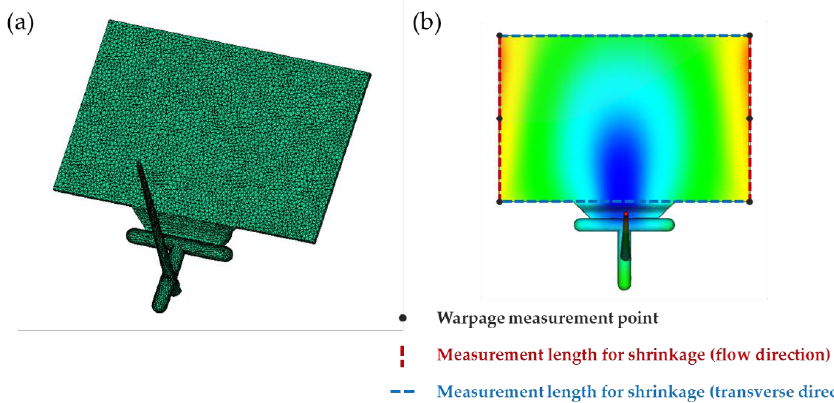
Figure 2. Shape of the test sample model: ( a ) mesh model, and ( b ) measurement points of shrinkage and warpage. Table 2. Selected factors and levels.